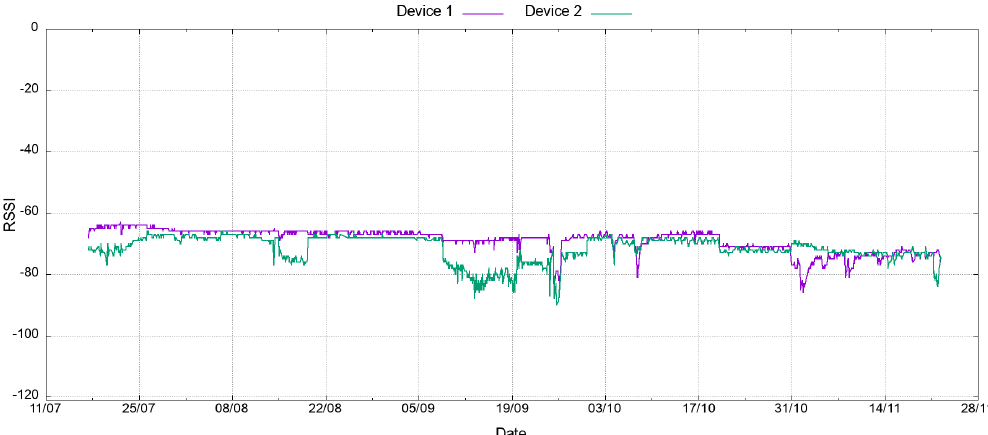
Figure 7. wM-Bus smart meter devices with unstable RSSI 1 (Location